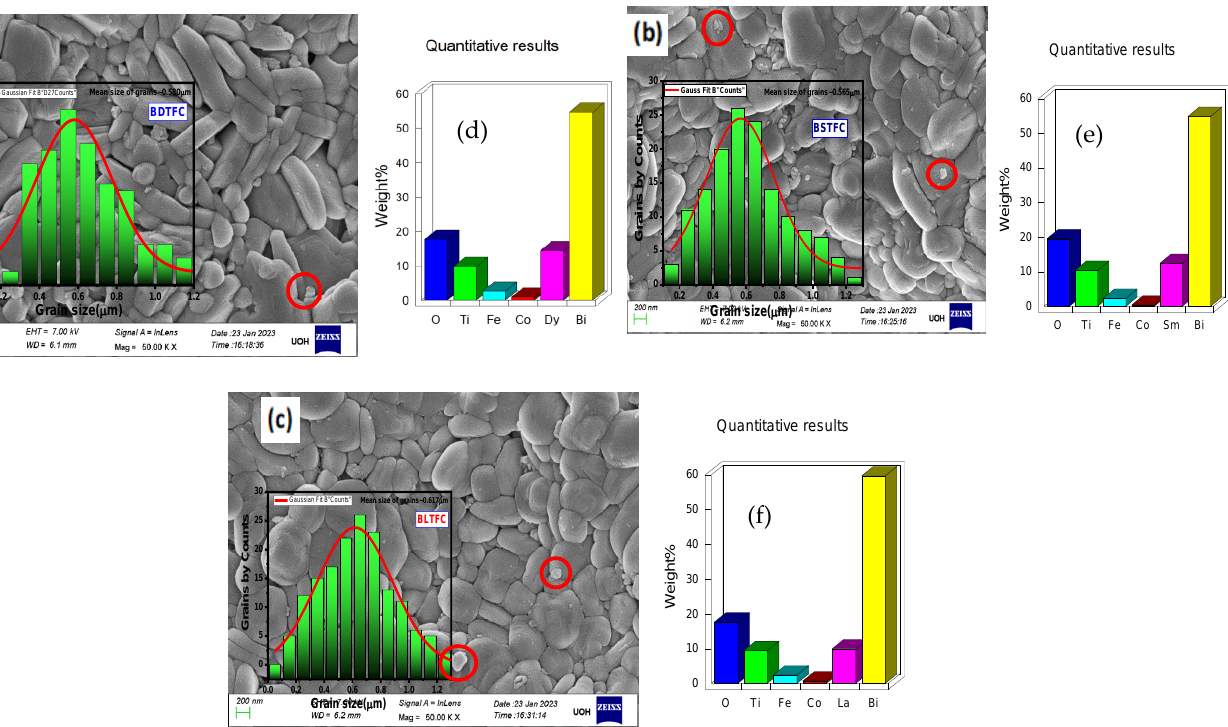
Figure 3. ( a – c ) SEM images and grain size distribution of BDTFC, BSTFC, and BLTFC, ( d – f ) EDAX of BDTFC, BSTFC, and BLTFC samples.